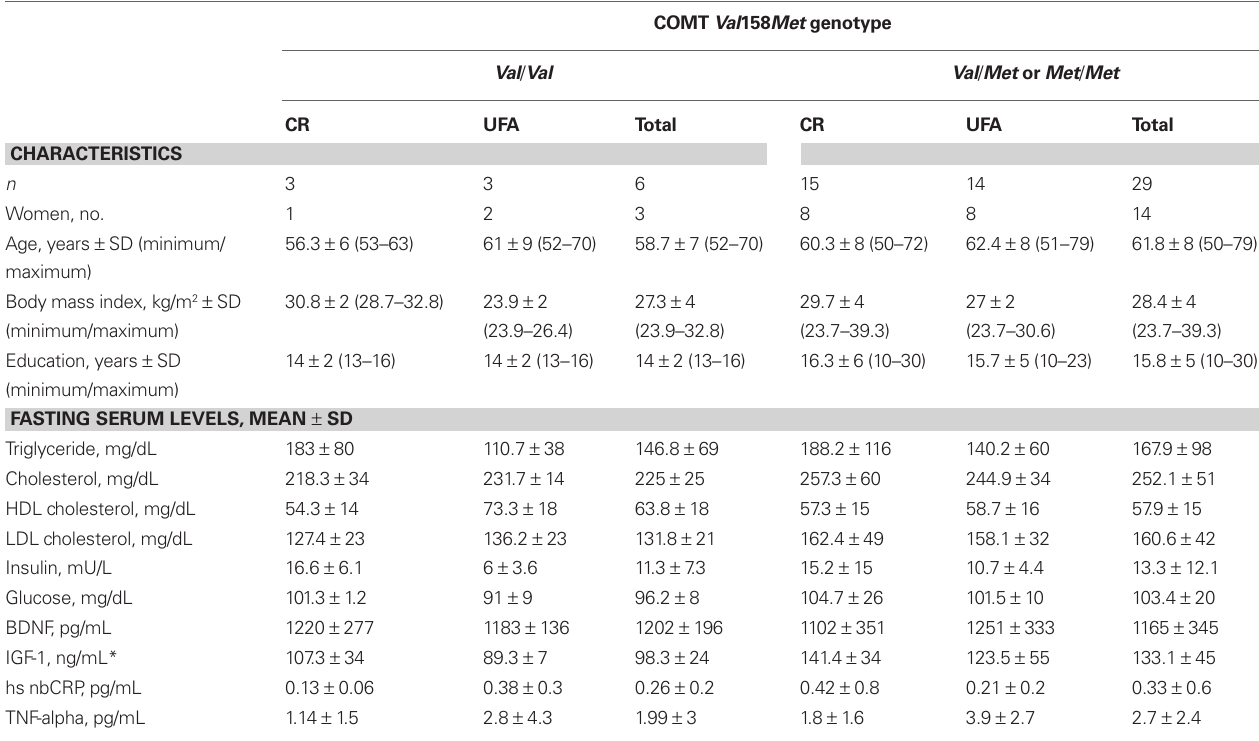
Table 1 | Demographic characteristics and fasting serum levels of COMT Val 158 Met genotype groups, dependent on intervention group and allelic